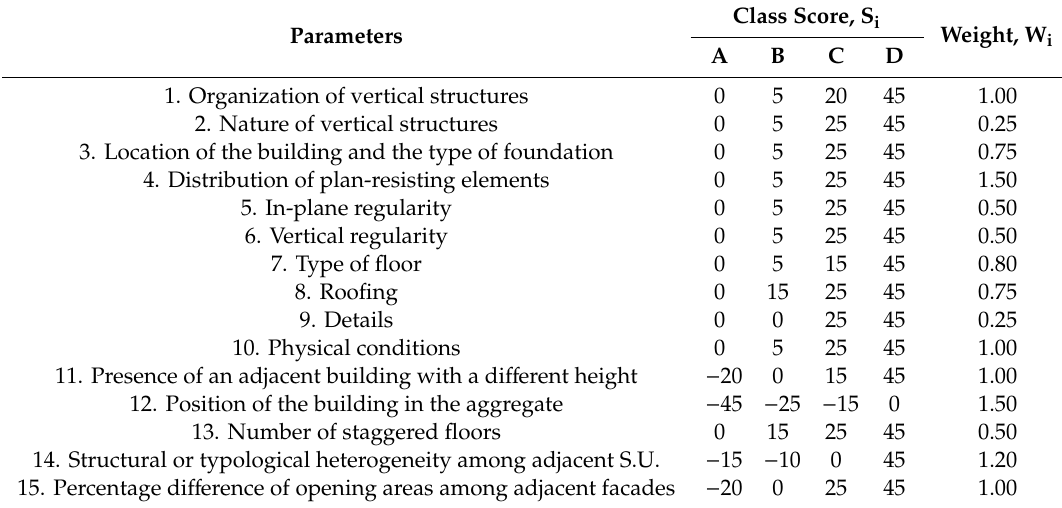
Table 2. Vulnerability form for historical clustered